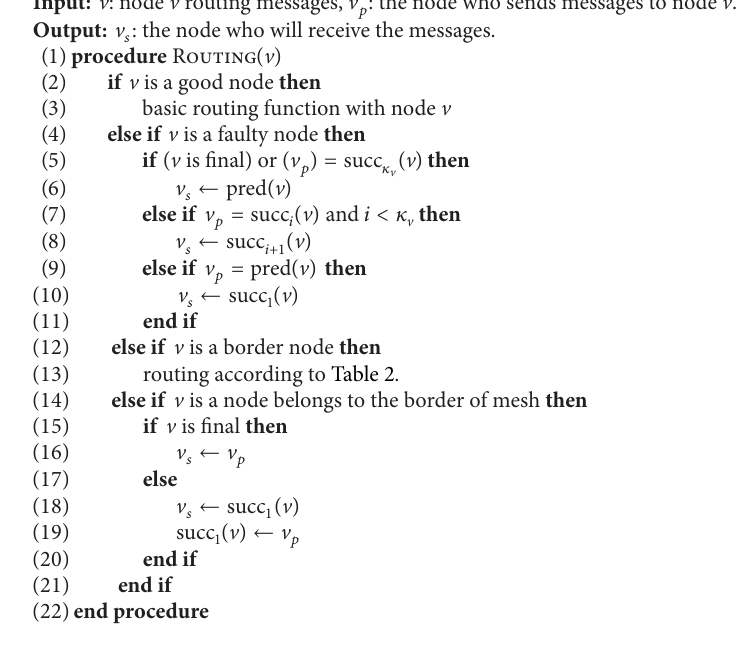
Algorithm 3: The novel routing algorithm based on cracky rectangular